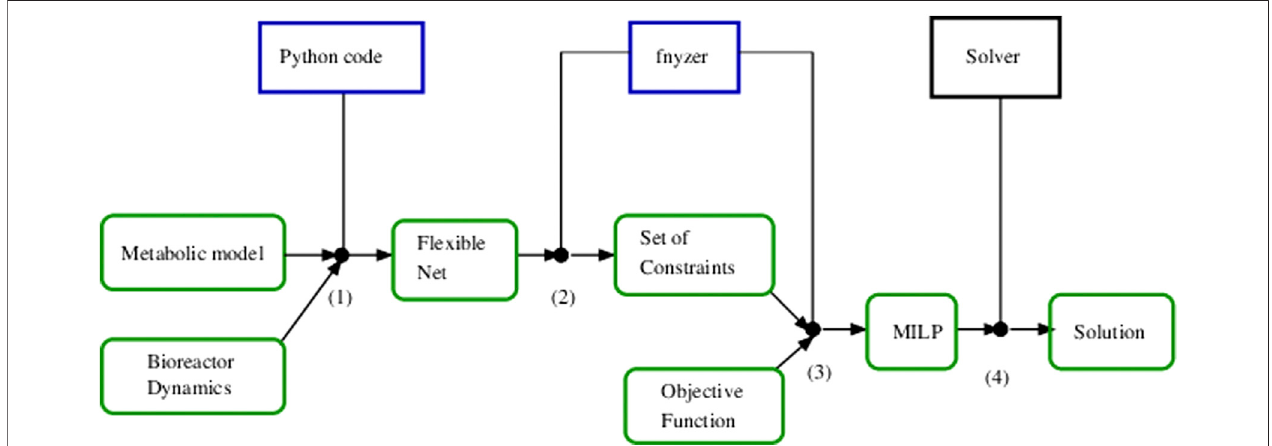
FIGURE 6 | Pipeline showing the steps performed to optimize the integrated model. (1) The metabolic model and the bioreactor dynamics are combined to generate aFlexibleNet that integrates the macroscopic (dilution rate, substrate concentration, cell density) and microscopic variables (intracellular metabolite fl uxes). (2) Asetofmathematicalconstraintsisderivedfromthenetspeci fi cationand (3) theobjectivefunctionisselected.Thetoolfnyzerperformsthegenerationofamixed-integer linear programming problem according to the set of constraints and the objective function. (4) Finally, the MILP problem is easily solved by using a solver (e.g., CPLEX, Gurobi, GLPK) that computes the mathematical solution.